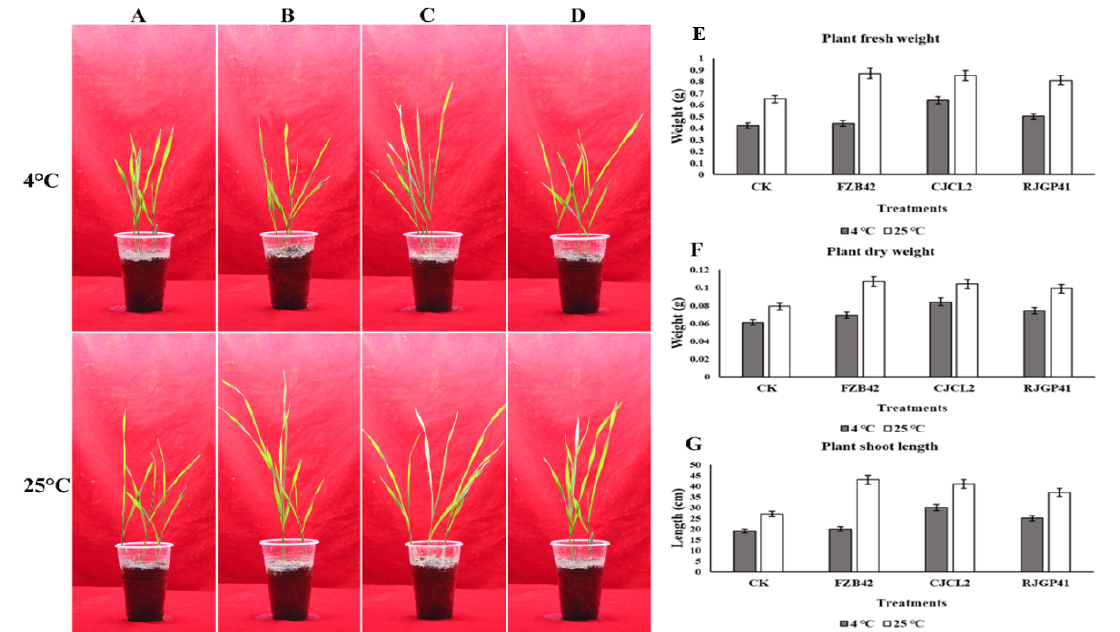
Figure 11. Un-inoculated wheat plants grown at optimum temperature and under cold stress ( A ) Wheat plants inoculated with Bacillus sp. FZB42 (B) Wheat plants inoculated with Bacillus sp. CJCL2 ( C ) Wheat plants inoculated with Bacillus sp. RJGP41 ( D ) Fresh weight of wheat plants grown under cold stress and at regular temperature with di ff erent bacterial treatments ( E ) Dry weight of wheat plants ( F ) Total length of wheat shoots grown under cold stress and at regular temperature with di ff erent bacterial treatments ( G ). The error bars on the graphs indicate the standard deviation of the mean ( n = 3). The significant di ff erence between the treatments was observed by using Tukey’s HSD test at p ≤ 0.05 and the experiment was repeated three